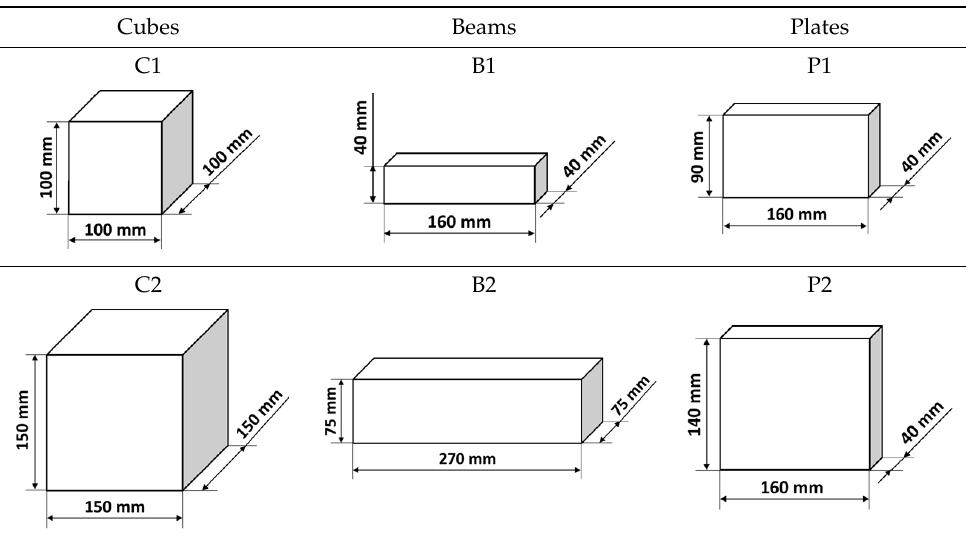
Table 3. Shape and dimensions of epoxy concrete samples used in the study.